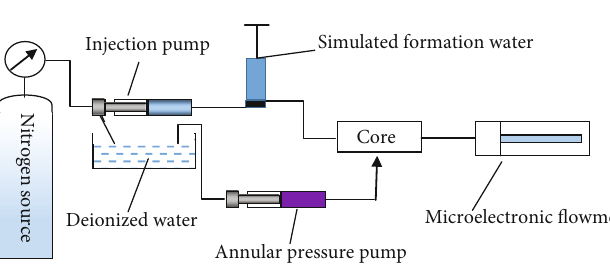
Figure 7: Flow chart of single-phase water drive experiment in tight core